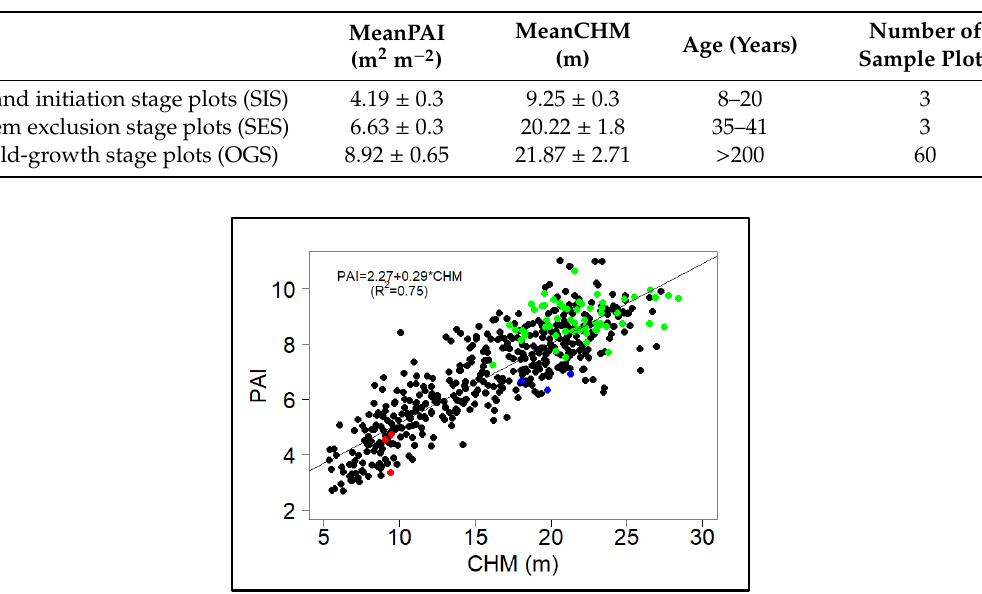
Figure 5. Relationship between PAI and canopy height model for all datasets. The regression model is illustrated by the black line. Red dots represent the PAI in SIS from the successional sample plots, blue dots represent the PAI in SES from successional sample plots, green dots represent PAI in OGS from Mo Singto sample plots, and black dots represent the PAI from LTS sample plots.